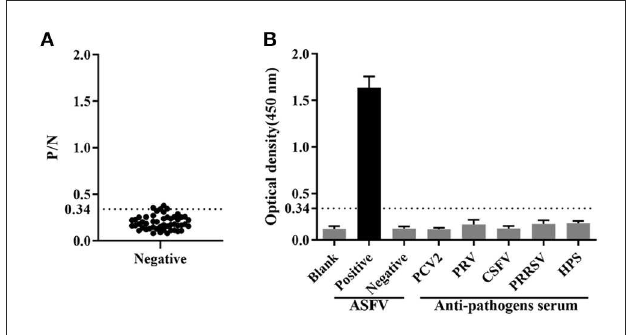
FIGURE5 Determination of sensitivity and specificity. (A) The cut-off value of the established ELISA. (B) The specificity was determined using positive serums against PCV2, PRV, CSFV, PRRSV and HPS.